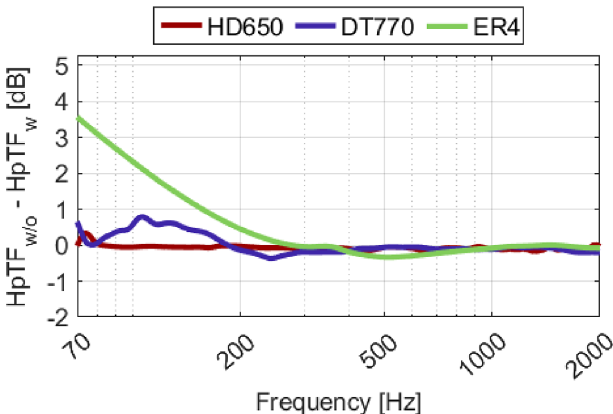
Figure 7. Mean differences between measurements on a head- phone test fi xture measured without probe tubes being present and with probe tubes inserted. The graph shows the difference of the ear simulator measurements, smoothed with an 1/12th octave band moving averaging window.